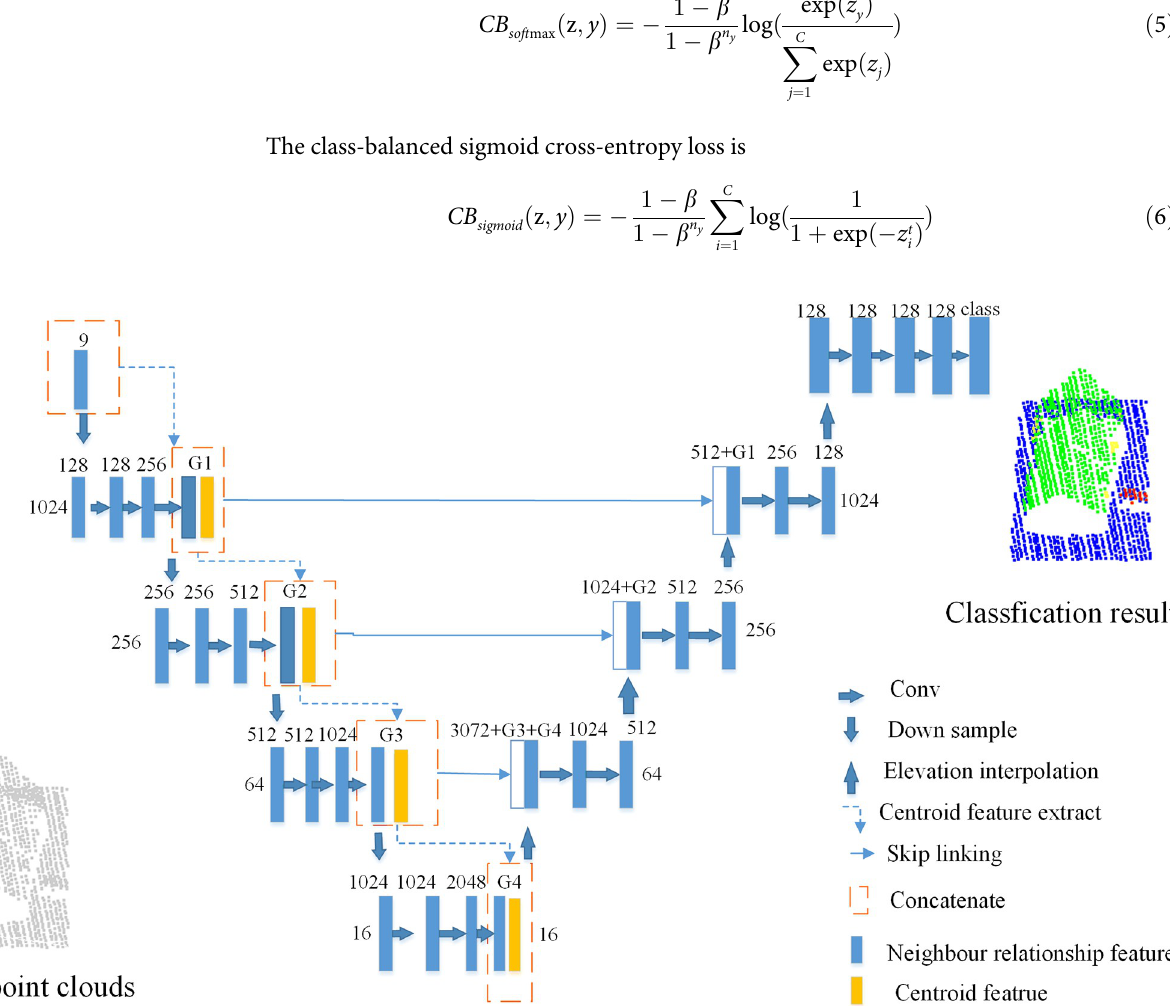
PLOS ONE | https://doi.org/10.1371/journal.pone.0280346 February 10,